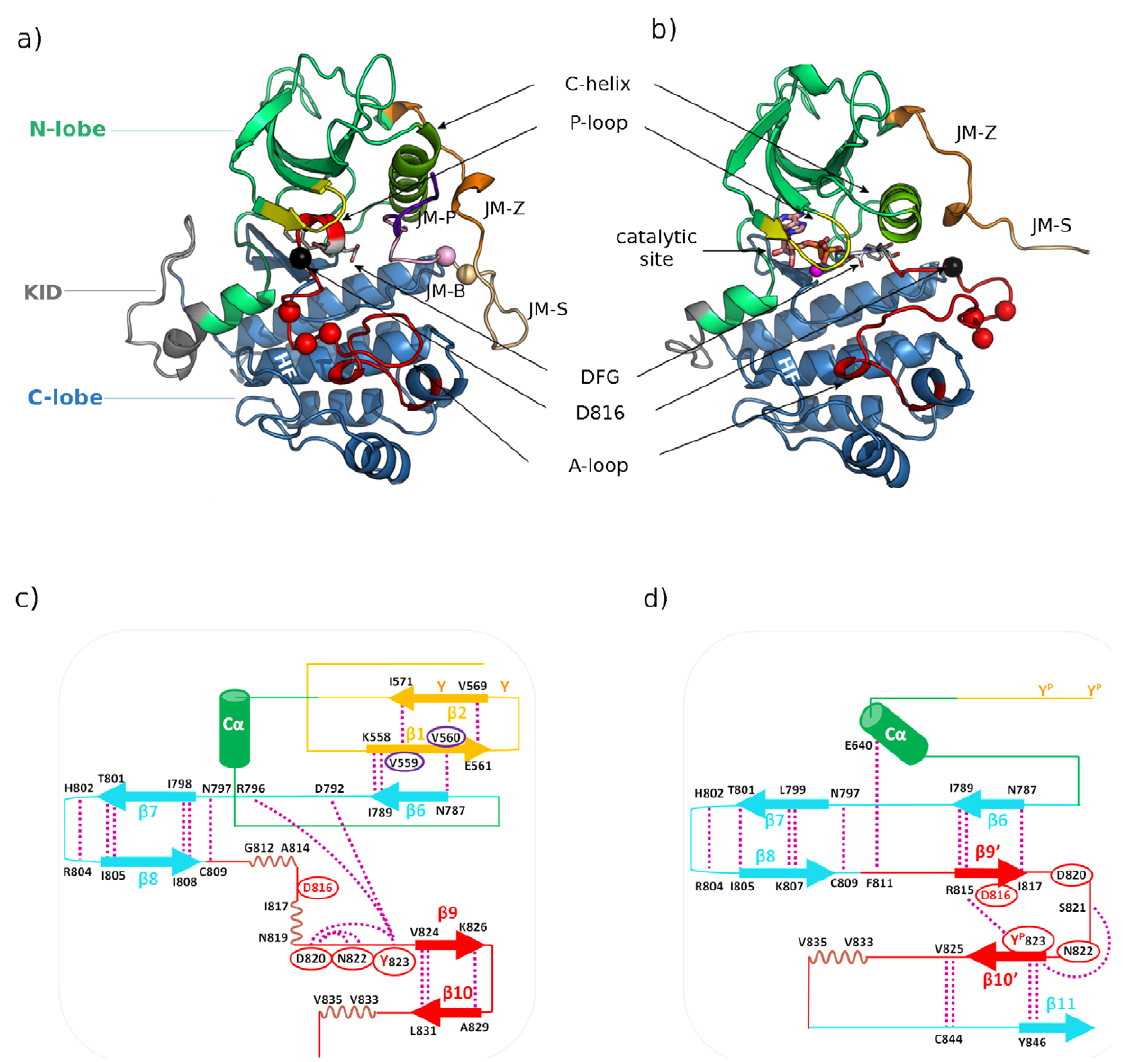
Figure 1. Structure of KIT cytoplasmic region in the inactive (auto-inhibited) and active states. Top : Cartoon representation of wild-type KIT crystallographic structures: ( a ) inactive (auto-inhibited) state (PDB code 1T45) and ( b ) active state (PDB code 1PKG). The different domains composing the cytoplasmic region and key structural elements are labeled and highlighted in color. The N-terminal proximal lobe (N-lobe) is in green, the C-terminal distal lobe (C-lobe) is in blue and in-between the kinase insert domain (KID) is in grey. The segments JM-Proximal (JM-P, in purple), JM- Buried (JM-B, in pink), JM-Switch (JM-S, in light orange) and JM-Zipper (JM-Z, in orange) composing the juxta-membrane region (JMR) are specified. The activation loop (A-loop) is in red - its DFG motif highlighted in licorice with white carbons, the C-helix is in lime and the glycine-rich P-loop is in yellow. F-helix (HF) in the C-lobe is labeled in white. The position of the catalytic site is indicated in the active structure ( b ), where the bound ligand ADP is drawn with licorice and the Mg 2 + ion is represented by a magenta sphere. The locations of mutational hot spot residues are indicated by spheres depicting the positions of their C a atoms, with the D816V mutation highlighted in black. Bottom : Schematic diagrams of the predicted secondary structure elements and interaction networks of JMR and A-loop: ( c ) inactive (auto-inhibited) state (1T45) and ( d ) active state (1PKG). JMR is in orange, N-lobe including C-helix (denoted C a ) is in green, C-lobe is in blue and A-loop is in red. Stabilizing H-bonds are drawn as dashed purple lines and the participating residues are labeled. Curved dashed purple lines represent turns. Phosphorylation sites Y568, Y570 and Y823 are highlighted. Encircled residues indicate mutational hot spots.